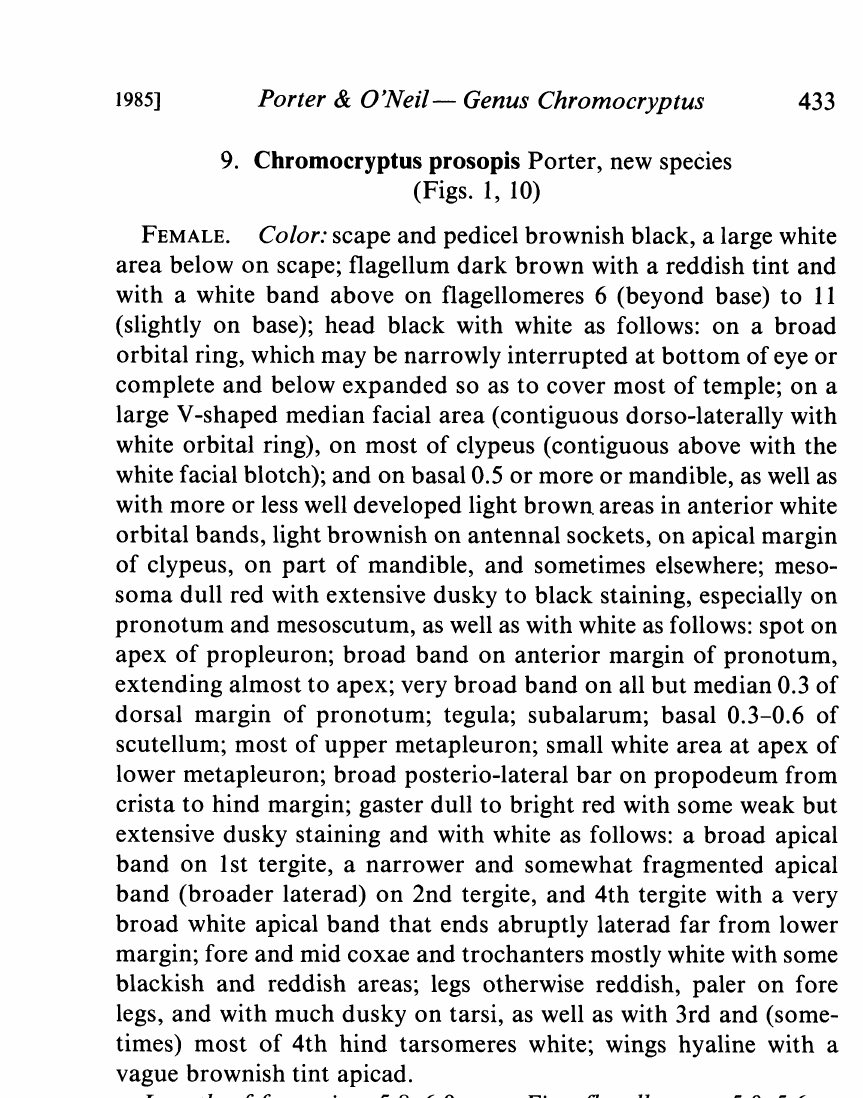
Color: scape and pedicel brownish black, a large white area below on scape; flagellum dark brown with a reddish tint and with a white band above on flagellomeres 6 (beyond base) to ll (slightly on base); head black with white as follows: on a broad orbital ring, which may be narrowly interrupted at bottom of eye